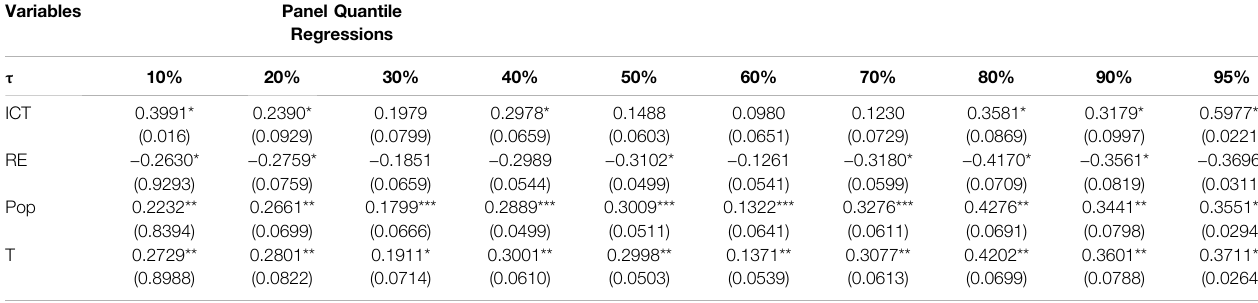
TABLE 7 | Panel quantile regression. Variables Panel Quantile